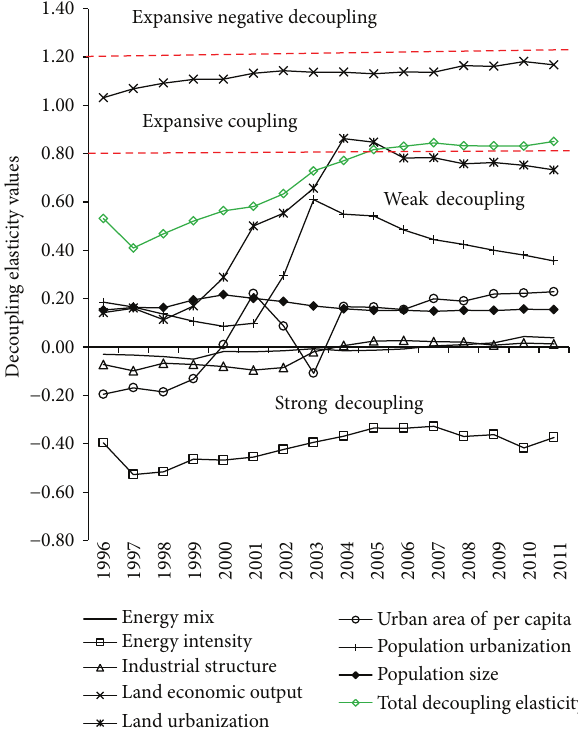
Figure 5: Change trends of each of decoupling elasticity values betweenenergy-relatedcarbonemissionandeconomicgrowthfrom 1996 to 2011.